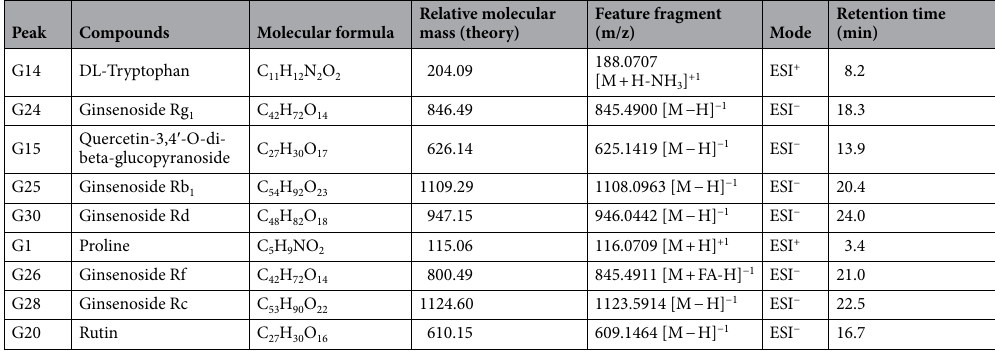
Table 4. Qualitative analysis of peaks relevant for the geographical origin